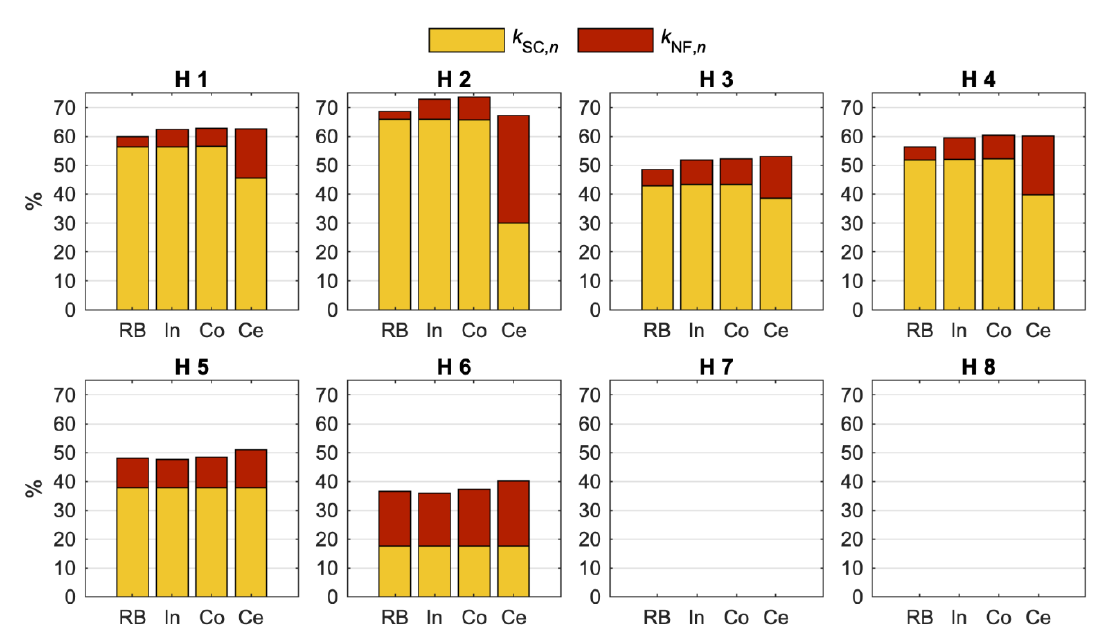
Figure B1. Allocation of the total neighborhood’s PV generation for the investigated EM concepts.